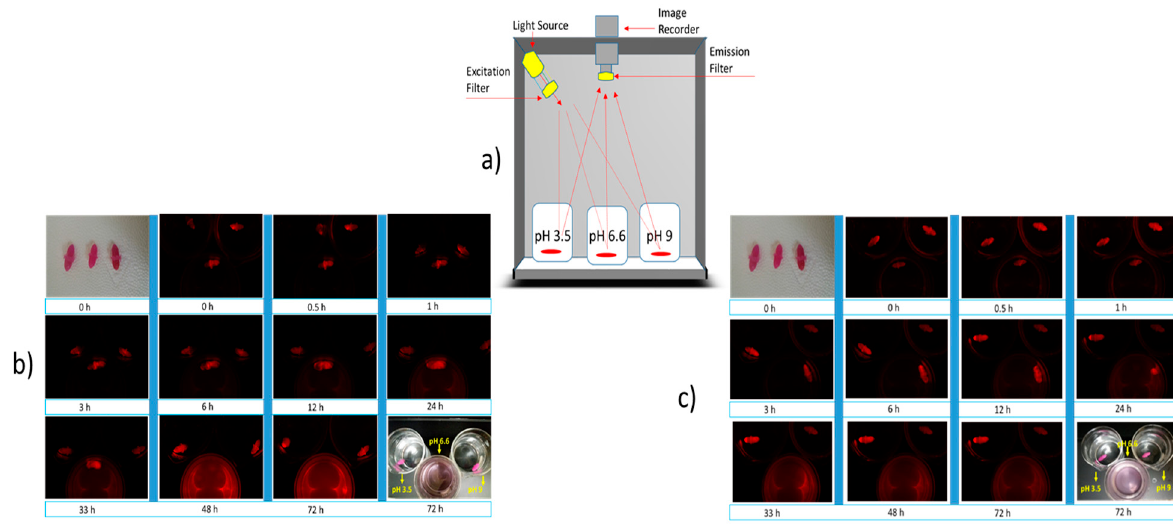
Figure 6. Real-time imaging of tablet disintegration in media with different pH. DilC-18 stain (red) was encapsulated into the capsule to study the pattern of drug release. ( a ) Imaging of alginate capsule at different time intervals. ( b , c ) Imaging of alginate and MMT-enhanced alginate capsule, respectively, at different time intervals.